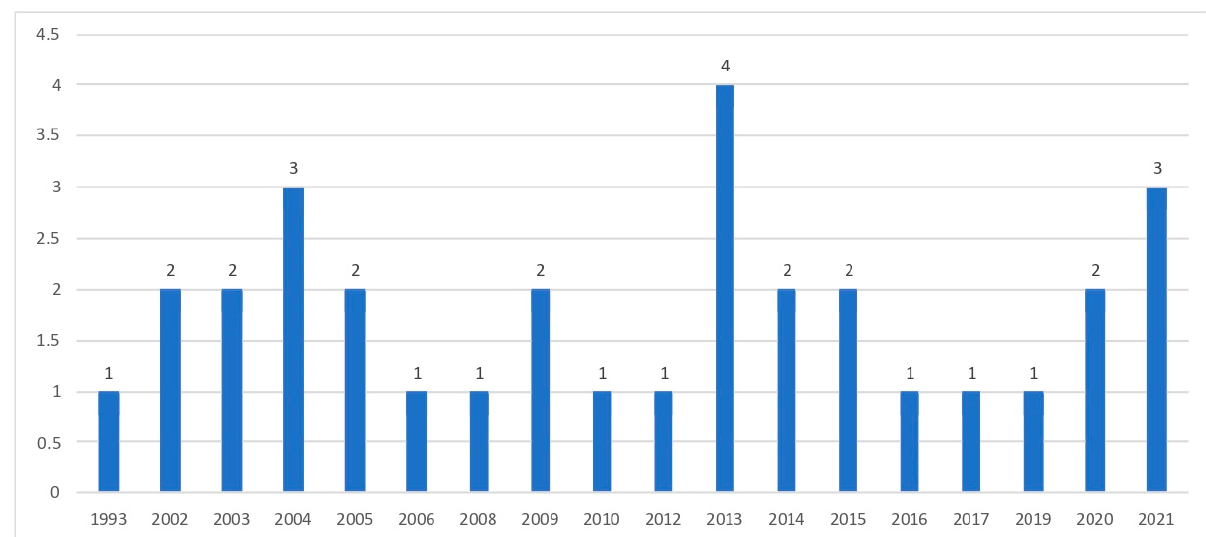
Figure 2. Distribution by year of publication.